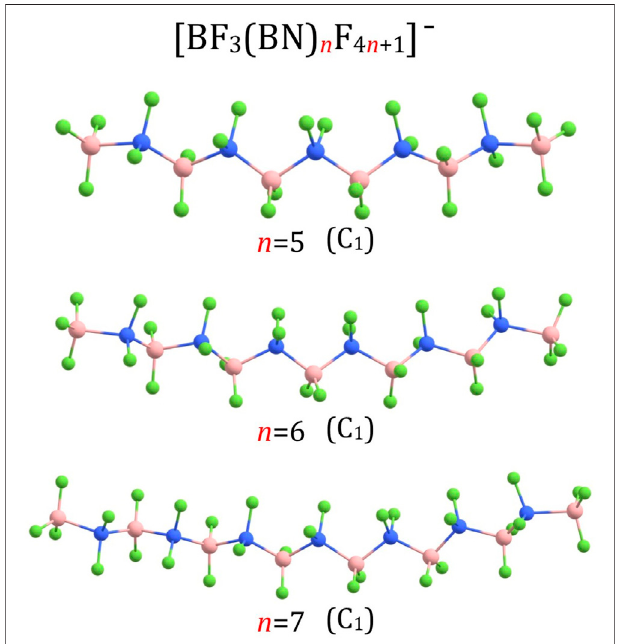
FIGURE 3 | Equilibrium structures of (BF 3 (BN) n F 4 n +1 ) – ( n = 5 – 7) anions (symmetry point group in parenthesis).